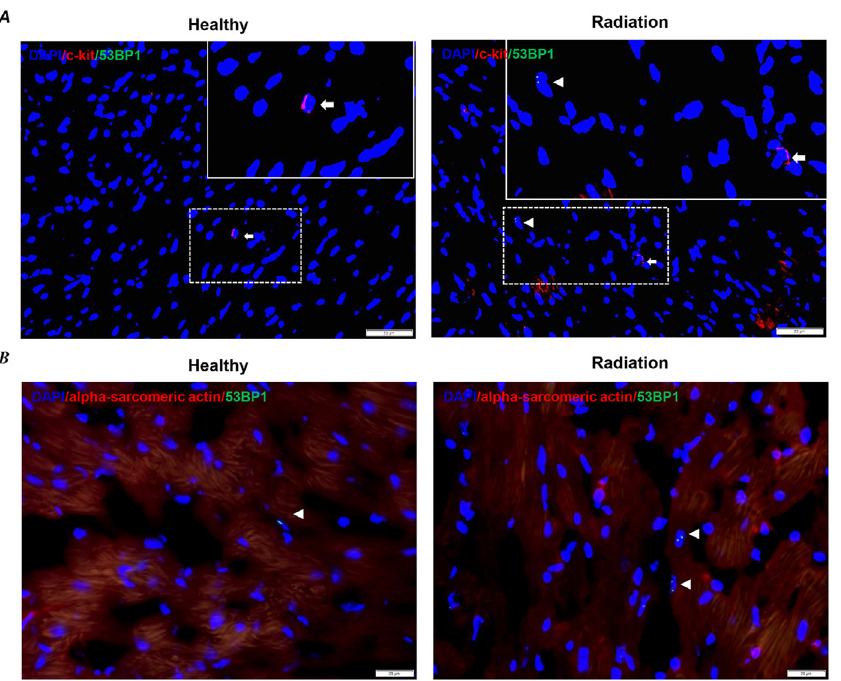
Fig 2. DNA damage in c-kit-positive stem cells and cardiomyocytes on heart sections. (A) Representative images of DNA damage (53BP1 foci) in c-kit-positive stem cells. Arrows and arrowheads indicate the c-kit-positive stem cells (red, c-kit) and 53BP1 foci (green dots), respectively. The nuclei were stained with DAPI. Scale bars: 50 μ m and 10 μ m (left), 20 μ m (right) for magnification. (B) Representative images of DNA damage (53BP1 foci) in cardiomyocytes. Arrowheads indicate the 53BP1 foci (green dots) in cardiomyocytes (red, alpha sarcomeric actin), respectively. The nuclei were stained with DAPI. Scale bars: 20 μ